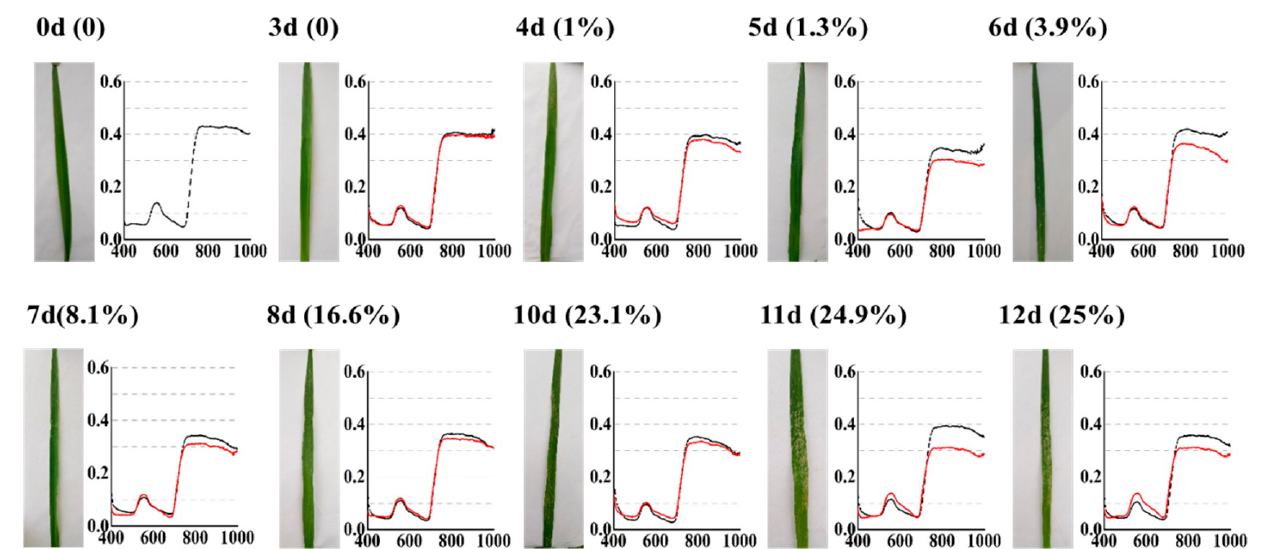
Figure 3. Reflectance changes of healthy (black line) and diseased (red line) wheat leaves after infection at the jointing stage. Note: X axis: Wavelength (nm); Y axis: reflectance; “12d (25%)” represents the 12th day after infection with an average DS of 25%.